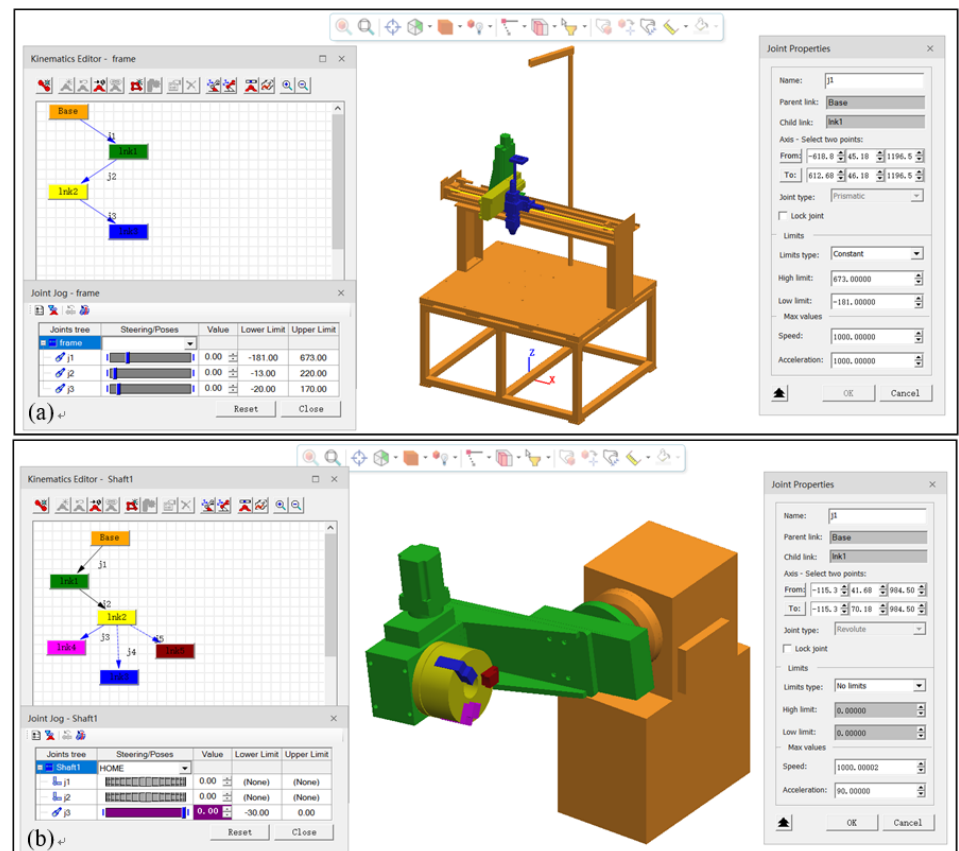
Figure 4. Movement setting of LMD equipment model: ( a ) Three-axis component movement setting, and ( b ) Rotary axis component movement setting.